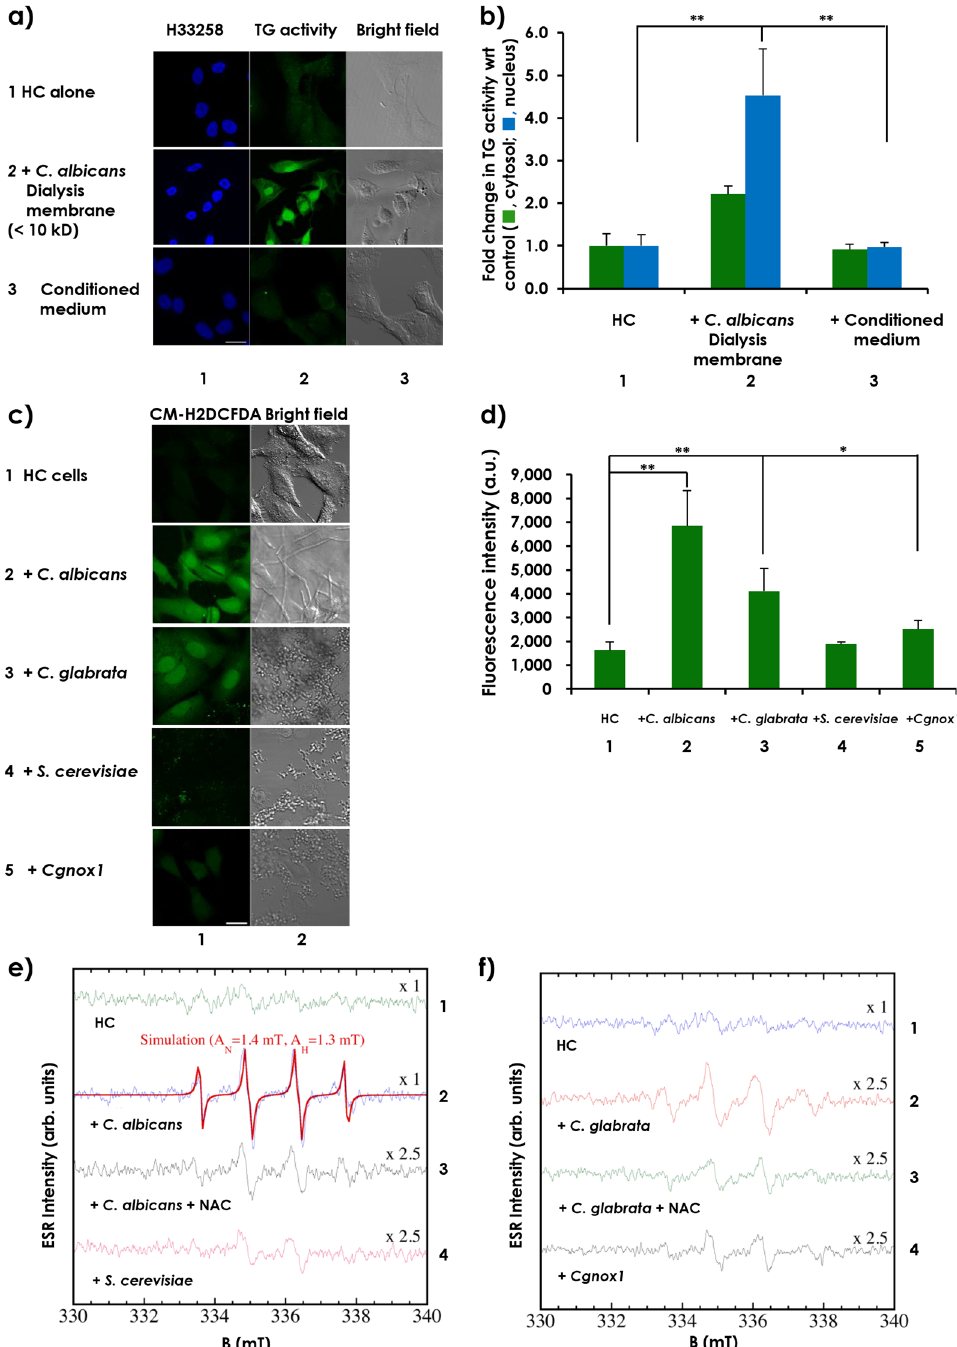
Figure 2. Levels of ROS in HC cell were increased following co-incubation with pathogenic Candida species. HC cells were seeded at 2 × 10 5 cells per well on a 35-mm glass-based dish or round cover slips plated in 6-well plates and were incubated overnight. ( a ) After adding 5-BAPA, the cells were incubated alone (row 1) or were co-incubated with 5 × 10 6 C. albicans cells grown in a transwell separated by a dialysis membrane (row 2) or with the conditioned medium prepared from C. albicans cultures following a 24-hour incubation (row 3). Representative images from at least 3 fields from 3 independent experiments are shown. ( b ) Fluorescence intensities of TRITC in both the cytoplasm and nucleus were quantitated using ZEN 2011 software, and the relative TG activity levels are presented in bar graphs with the levels from the HC cells incubated alone as the control (mean ± SD, n = 3). ( c ) Cells were incubated alone (row 1) or were co-incubated for 8 hours with the different fungal strains, including C. albicans (row 2), C. glabrata (row 3), S. cerevisiae (row 4), and the CgNOX1 gene-targeted mutant of C. glabrata (row 5), with 5 µ M CM-H2DCFDA. Scale bars = 20 µ m. ( d ) Fluorescence intensities from reacted CM-H2DCFDA were quantitated using ZEN 2011 software and are represented in bar graphs (mean ± SD, n = 3). A 100- µ L test mixture was prepared containing 40 µ L DPTA, 10 µ L BMPO and ( e ) 50 µ L of culture medium from the HC cells (spectrum 1) or HC cells co-incubated with C. albicans in